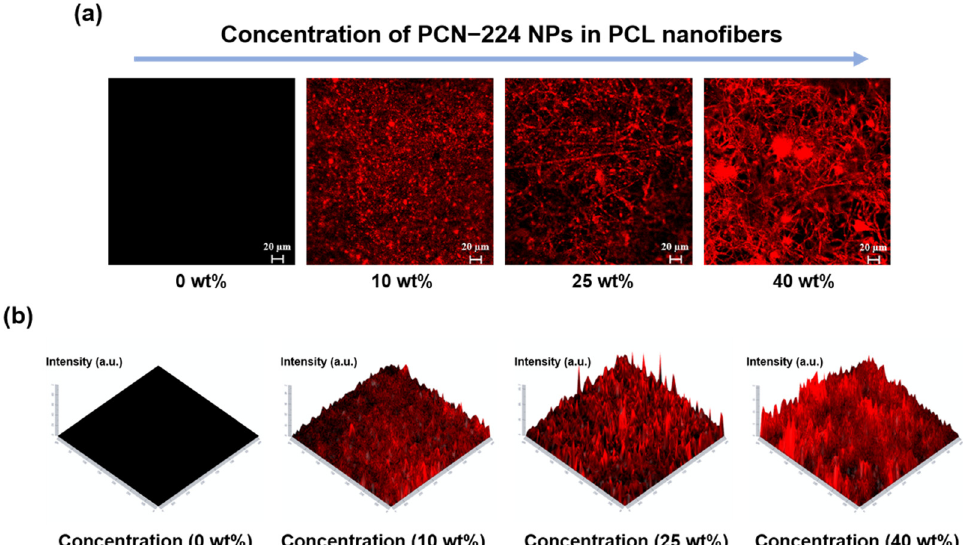
Figure 6. ( a ) The confocal laser scanning microscope (CLSM) images of various PM membranes with different PCN − 224 NPs content and ( b ) their normalized fluorescence intensity and distribution ( λ ex = 430 nm).